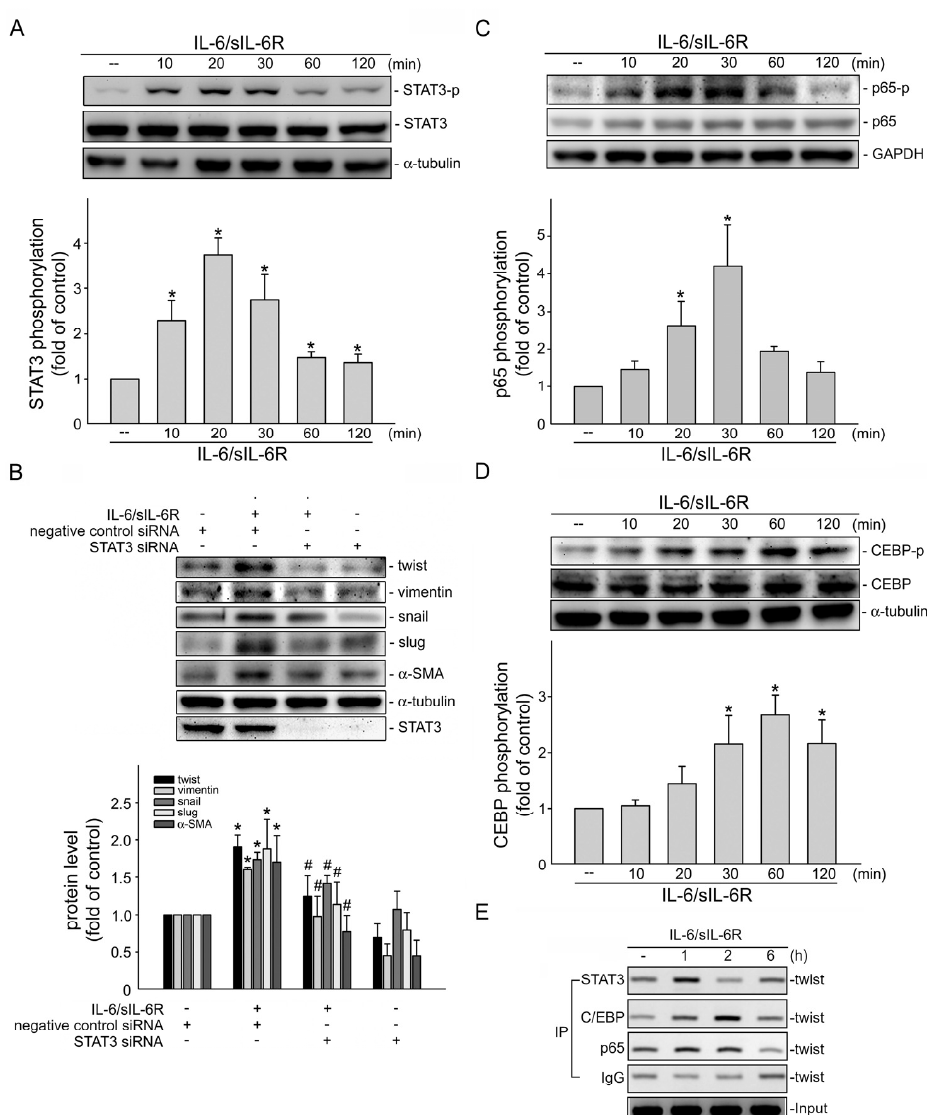
Figure 2. STAT3 mediates IL-6/sIL6R-induced EMT in HCT116 cells. ( A ) HCT116 cells were stimu- lated by IL-6/sIL-6R (20 ng/mL) for indicated time periods. After stimulation, immunoblotting was employed to determine the STAT3 phosphorylation status. Bar graph represents the mean ± S.E.M. of five independent experiments. * p < 0.05, compared with the control group. ( B ) HCT116 cells were transfected transiently with STAT3 siRNA or negative control siRNA for 48 h. After transfection, cells were stimulated by IL-6/sIL-6R (20 ng/mL) for another 48 h. Immunoblotting was used to ex- amine the protein levels of Twist, vimentin, Snail, slug, α -SMA or STAT3. Bar graph represents the mean ± S.E.M. of four independent experiments. * p < 0.05, compared with the control group; # p < 0.05, compared with the group treated with IL-6/sIL6R (20 ng/mL). HCT116 cells were stimulated by IL-6/sIL6R (20 ng/mL) for different time periods as indicated. The p65 ( C ) or C/EBP ( D ) phos- phorylation status was examined using immunoblotting. Bar graph represents the mean ± S.E.M. of five independent experiments. * p < 0.05, compared with the control group. ( E ) Cells were stimulated by IL-6/sIL-6R (20 ng/mL) for 1, 2 or 6 h. A ChIP assay was performed as described in “Materials and Methods” Section 4. Typical traces representative of three independent experiments with simi- lar results are shown. Before immunoprecipitation, the promoter region ( − 742/ − 349) of Twist was detected in the cross-linked chromatin sample (input, positive control).